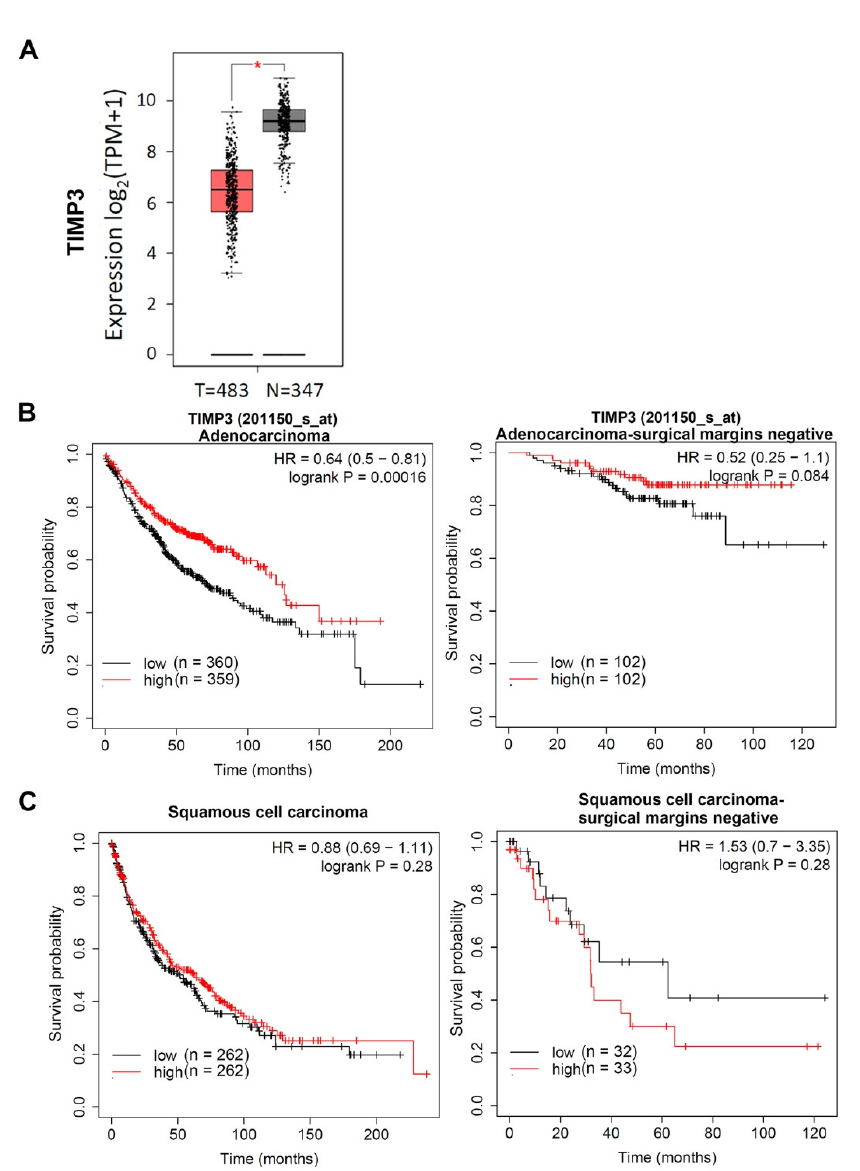
Figure 1. Clinical significance of tissue inhibitor of metalloproteinases (TIMP)-3 in lung adenocarcinoma (LADC). ( A ) Gene expressions of TIMP-3 between tumor and normal samples in the combined data of The Cancer Genome Atlas (TCGA)-LADC and Genotype-Tissue Expression (GTEx) cohorts. ( B and C ) Correlation between TIMP-3 expression and the overall survival rate in LADC and squamous cell carcinomas using the Kaplan–Meier plotter database. Gene expressions were dichotomized into high and low values using the median as a cuto ff . HR—hazard